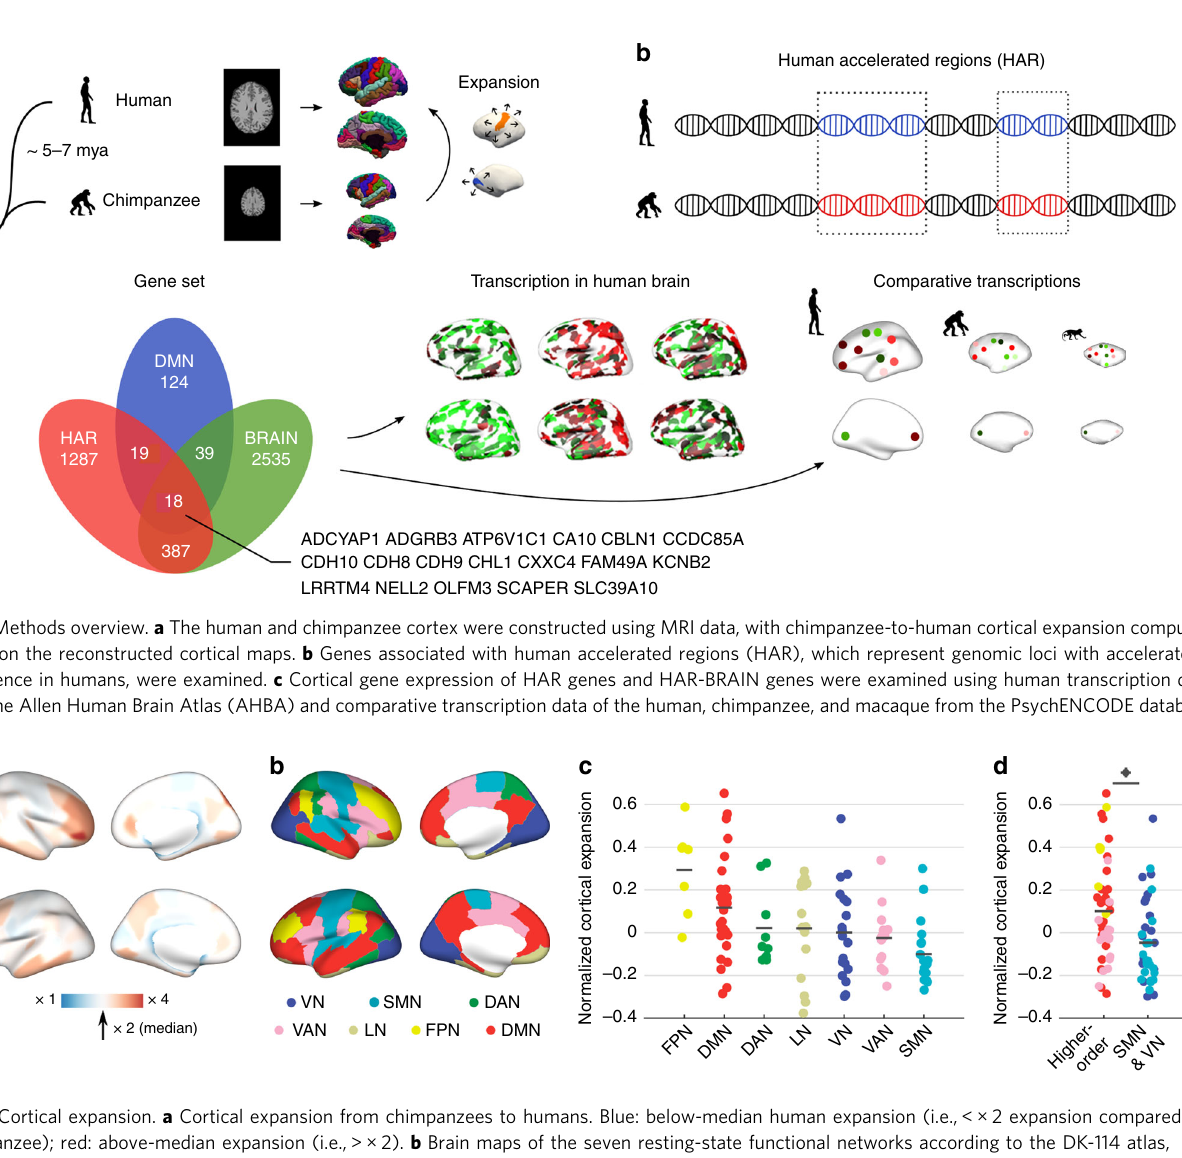
Fig. 2 Cortical expansion. a Cortical expansion from chimpanzees to humans. Blue: below-median human expansion (i.e., < × 2 expansion compared to chimpanzee); red: above-median expansion (i.e., > × 2). b Brain maps of the seven resting-state functional networks according to the DK-114 atlas, describing the visual (VN), somatomotor (SMN), dorsal-attention (DAN), limbic (LN), ventral-attention (VAN), frontal-parietal (FPN), and default-mode network (DMN). c Levels of normalized cortical expansion per functional network in descending order of mean expansion. d Levels of normalized cortical expansion in higher-order cognitive networks (DMN, FPN, VAN) versus the SMN and VN. Dots depict cortical regions. Colors represent functional networks, as in panel b . Central marks are mean expansions. * indicates a two-sided p -value < 0.05, FDR corrected, two-sample t -test. Source data provided as Source Data fi